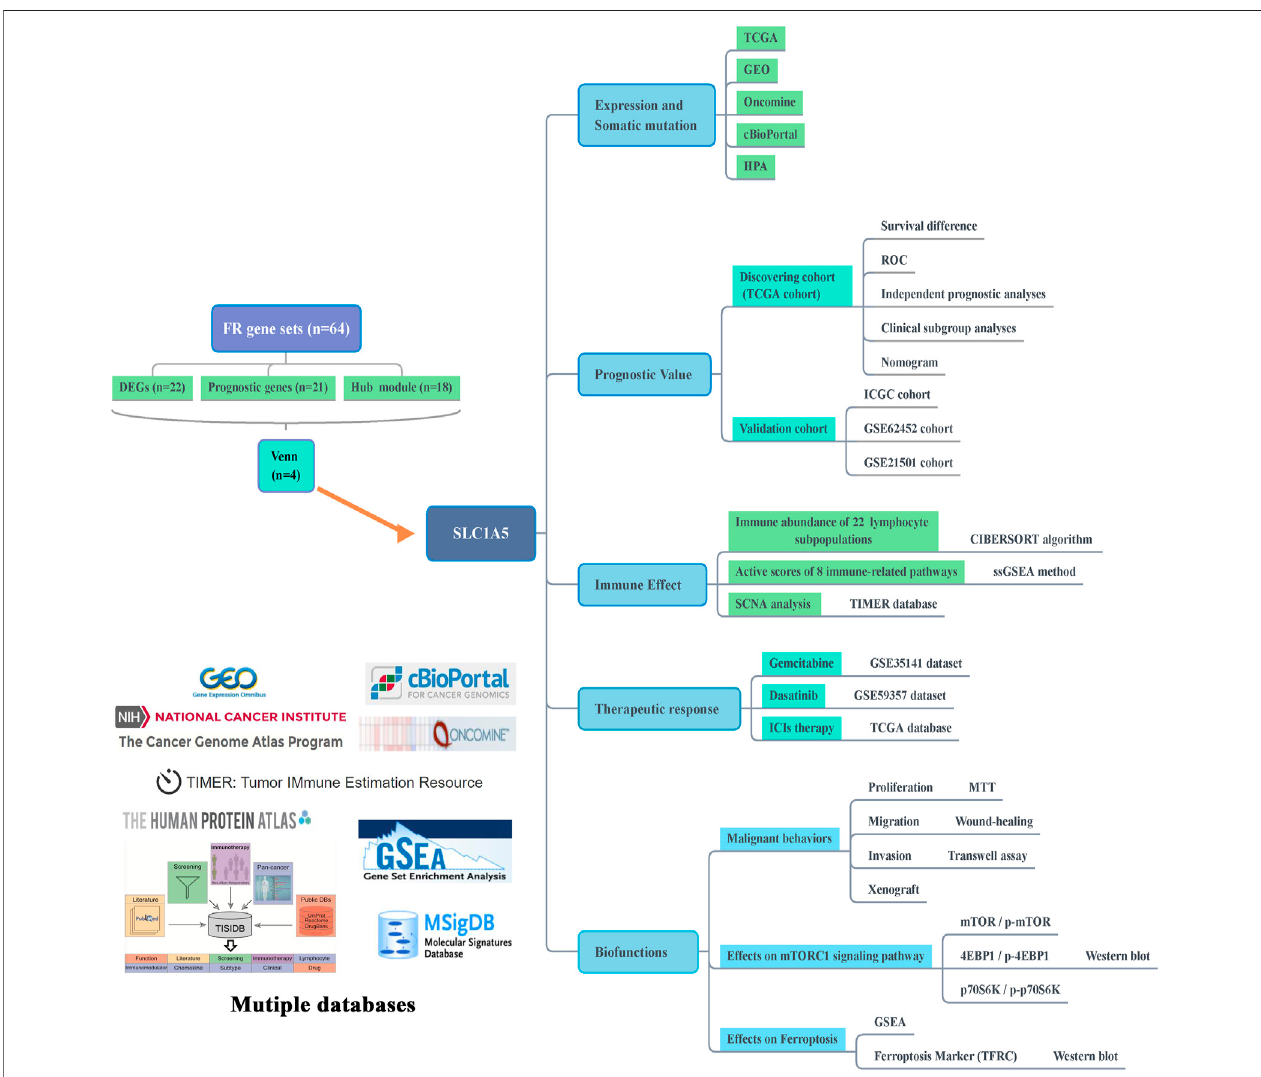
FIGURE1 | Flow chart of this study. FR, ferroptosis-related; DEGs, differentially expressed genes; TCGA, The Cancer Genome Atlas; GEO, Gene Expression Omnibus;HPA,HumanProteinAtlas;ROC,receiveroperatingcharacteristiccurve;ICGC,InternationalCancerGenomeConsortium;ssGSEA,single-samplegene set enrichment analysis; SCNA, somatic copy number alteration; ICIs, immune checkpoint inhibitors; GSEA, gene set enrichment analysis; TFRC, transferrin receptor.